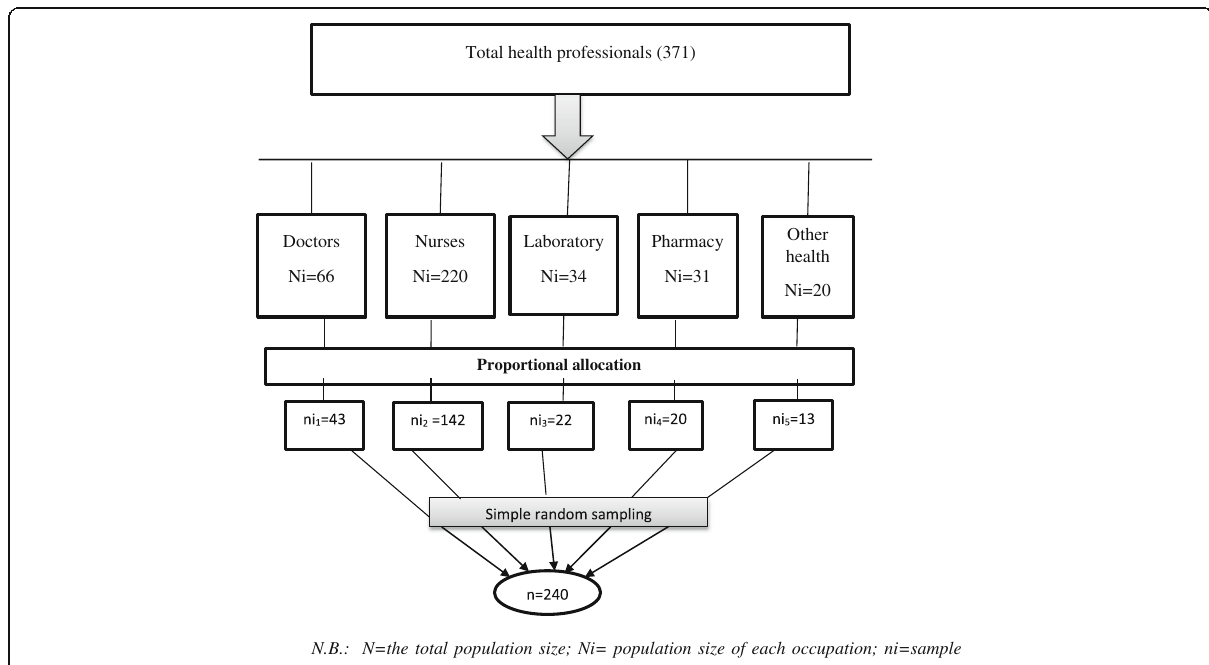
Fig. 1 Schematic presentation of the sampling technique. N.B.: N = the total population size, Ni = population size of each occupation, ni = sample size drawn from each occupation/profession, n = sample size